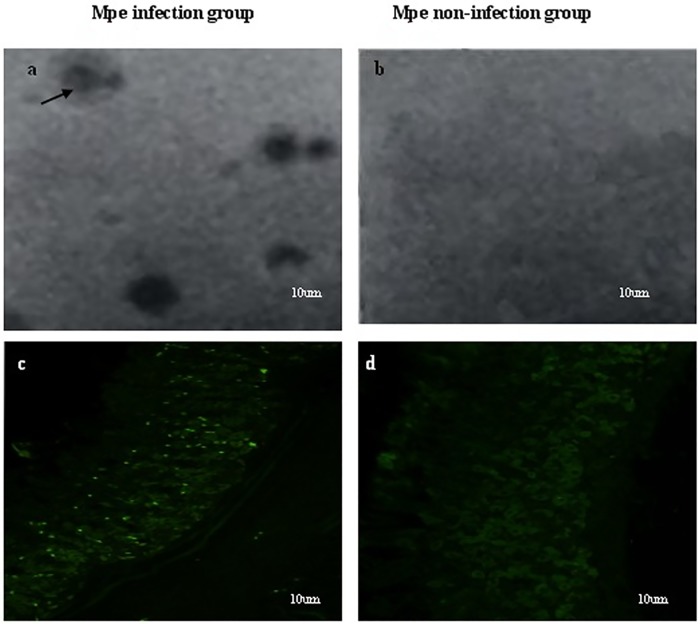
Detection of Mpe infection in gastric mucosa of immunodeficient mice.a. "fried egg" colonies indicating the possible presence Mpe infection. b. No colonies were detected in non-infection groups. c. Point green fluorescence observed in mouse gastric mucosa cells infected with Mpe. d. Absence of specific green fluorescence in mouse gastric mucosa sections taken from the Mpe non-infected mice. All sections were stained with FITC and examined using fluorescence microscope and photographed. Data is representative of three independent experiments (n = 3).